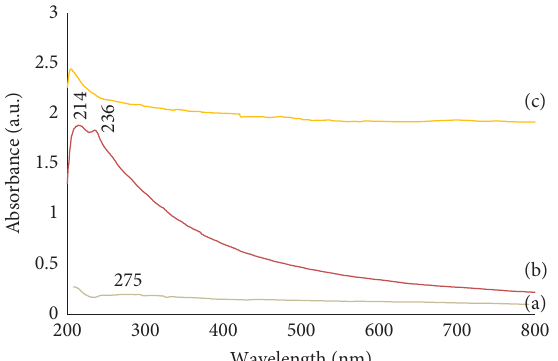
Figure 6: UV-vis spectroscopy analysis of the alginate biopolymer (a), zirconia NPs (b), and alginate/zirconia nanocomposites